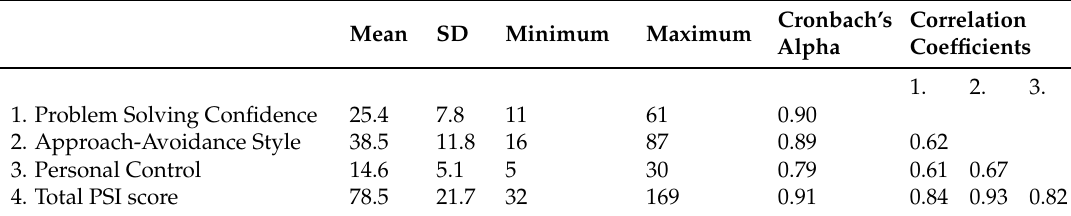
Table 2. Mean values, correlations, intercorrelations and Cronbach’s alpha coefficients for the Problem Solving Inventory